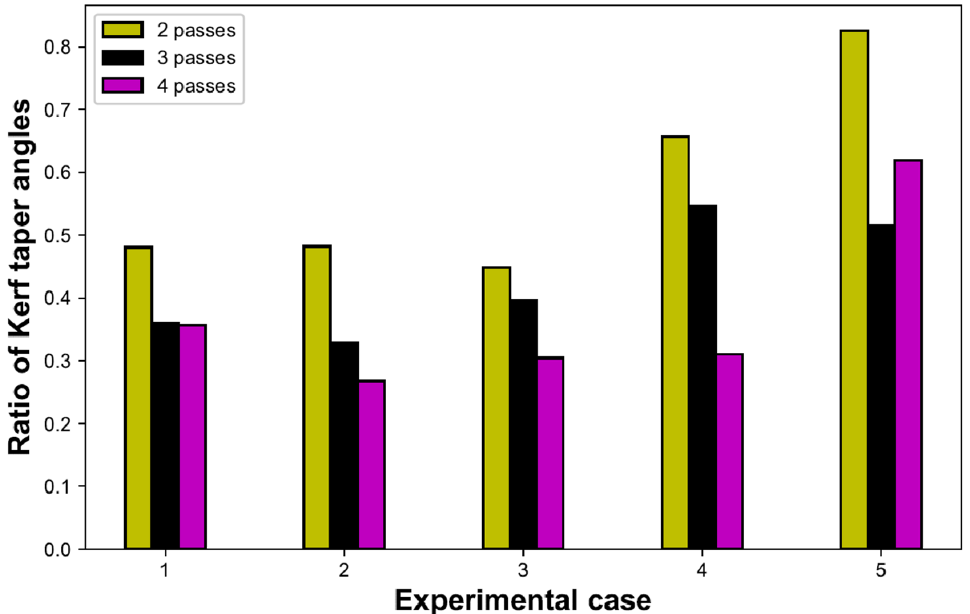
Figure 8. Ratio of kerf taper angle obtained with 2, 3, or 4 passes, with respect to the taper angle of the first pass under various experimental conditions. the first pass under various experimental